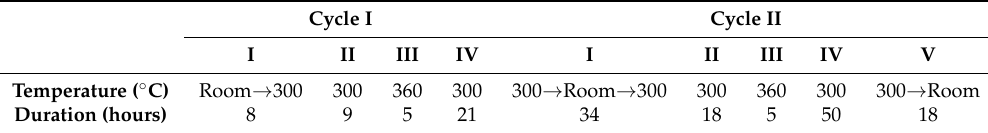
Table 2. Temperature cycles between room temperature and 360 ◦ C.